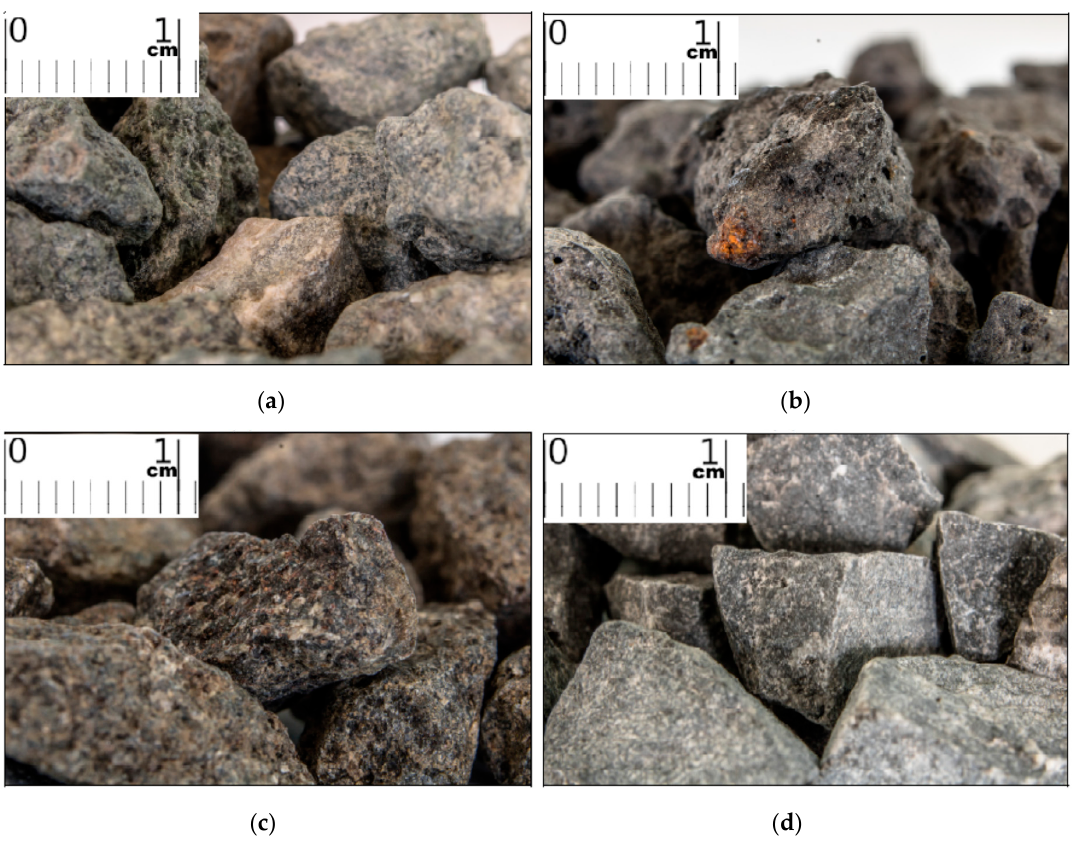
Figure 1. Selected aggregates: ( a ) Basalt (ID: R); ( b ) EAF slags (ID: A); ( c ) kinginzite (ID: K); ( d ) limestone (ID: C).